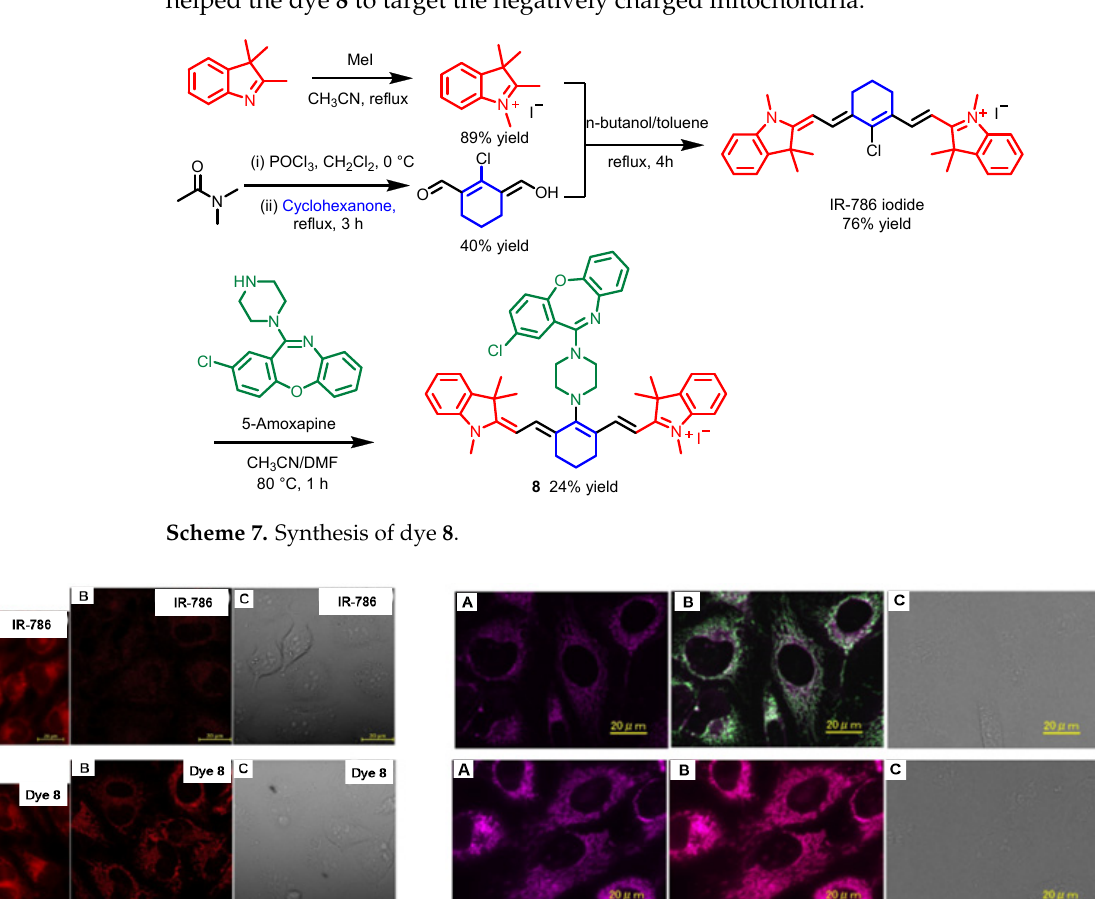
8 of 38 Figure 7. Confocal fluorescence images of HeLa cells and a zebrafish stained with 7a and Hoechst 33342. ( a ) Bright field image, ( b ) fluorescence image, ( c ) merged images. Top : High content screen- ing images of HeLa cells stained with 7a and Hoechst 33342. Red channel: 7a (490–515 nm); blue channel: Hoechst 33342 (350 nm). Bottom : High content screening images of zebrafish stained with 7a. Red channel (490–515 nm). Adapted from [24].